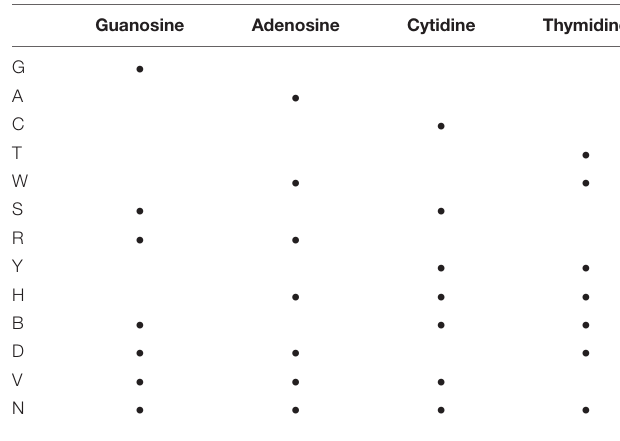
TABLE 1 | Reference table for commonly used one letter abbreviations representing different nucleic acid